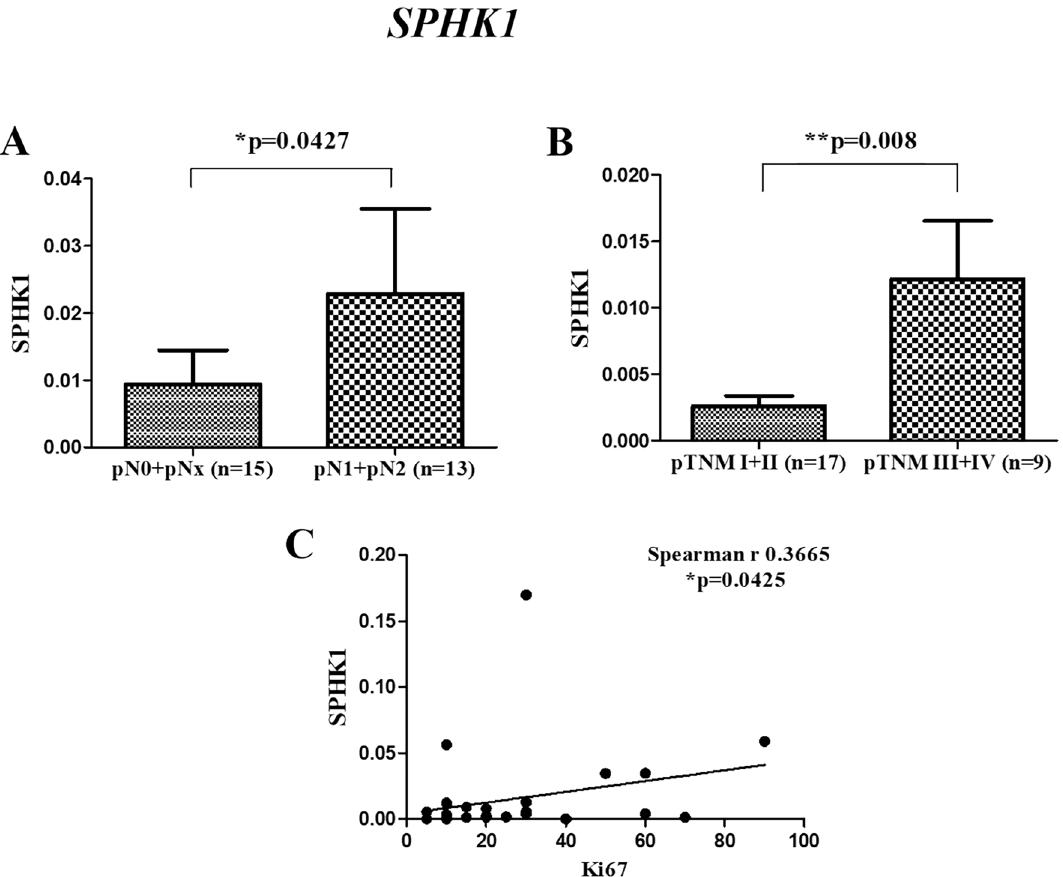
Figure 3. Correlation of SPHK1 gene expression with various clinicopathological characteristics in breast tumor tissues. ( A ) pN Stage (pN0 + pNx- [Nodal Negative], pN1 + pN2-[Nodal Positive]) ( B ) pTNM Stage (pTNM I + II- [early stage], pTNM III + IV- [late stage]) ( C ) Correlation with